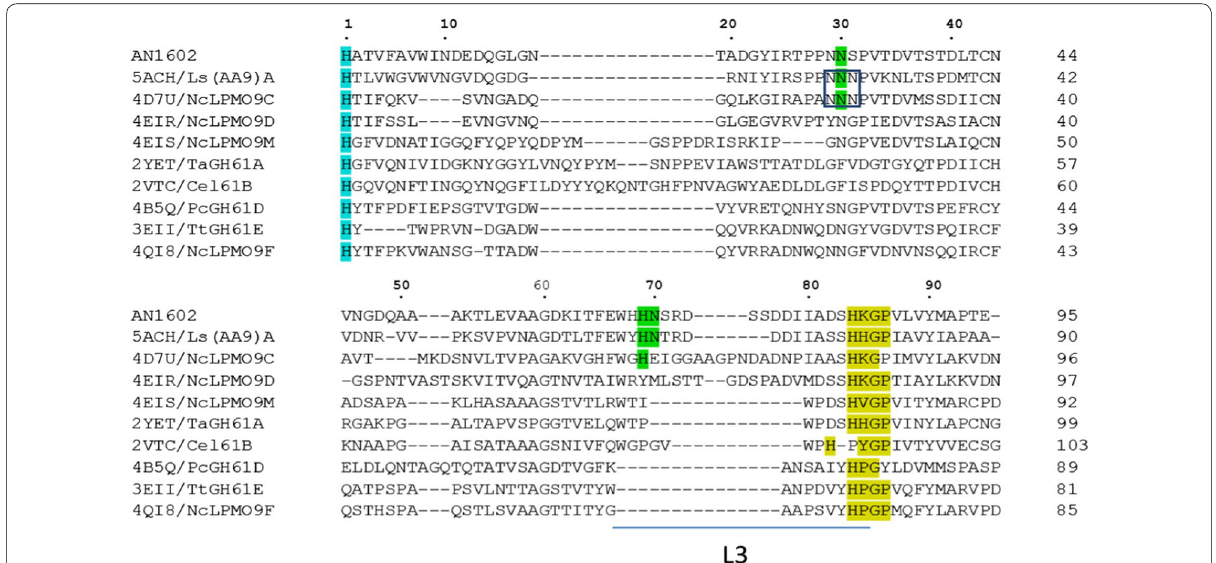
Fig. 5 Sequence alignment of AN1602 and AA9-LPMOs with known structures. The proteins included (PDB ID in parenthesis) are: Ls (AA9)A (5ACH), Nc LPMO9C (4D7U), Nc LPMO9D (4EIR), Nc LPMO9M (4EIS), Ta GH61A (2YET), Cel61B (2VTC), Pc GH61D (4B5Q) Tt GH61E (3EII) and Nc LPMO9F (4QI8). Conserved residues Asn30, His69 and His70 in AN1602 and their equivalent residues in Ls (AA9)A and Nc LPMO9C that potentially determine the activity on cello-oligomers are highlighted in green. Conserved His1 is shown in turquoise. Cluster of three consecutive aspargine residues in NcLPMO9C and Ls(AA9)A is boxed. Residues corresponding to Insertion loop L3 is shown as a horizontal bar below the